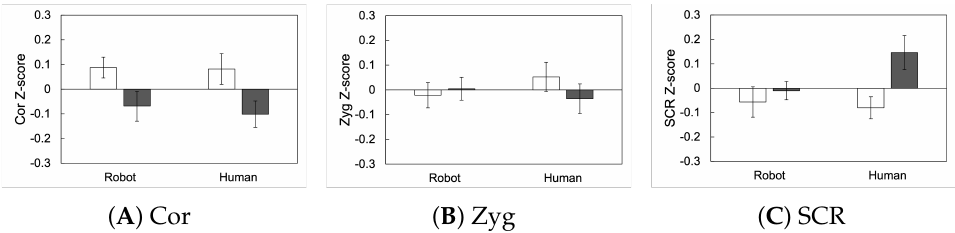
Figure 8. The mean with SE of the physiological evaluation. Cor: corrugator supercilii EMG; Zyg: zygomatic major EMG; SCR: skin conductance